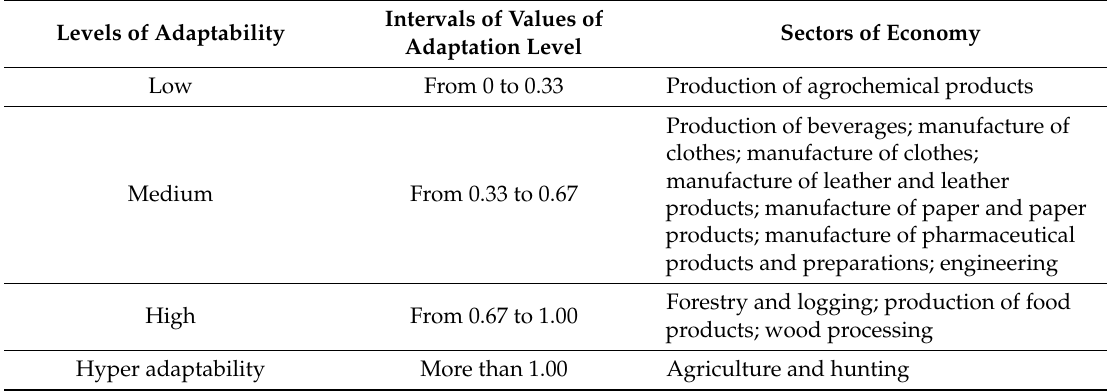
Table 3. The division of sectors of the economy of Ukraine in terms of their adaptability to the rise of prices for energy carriers in 2015.